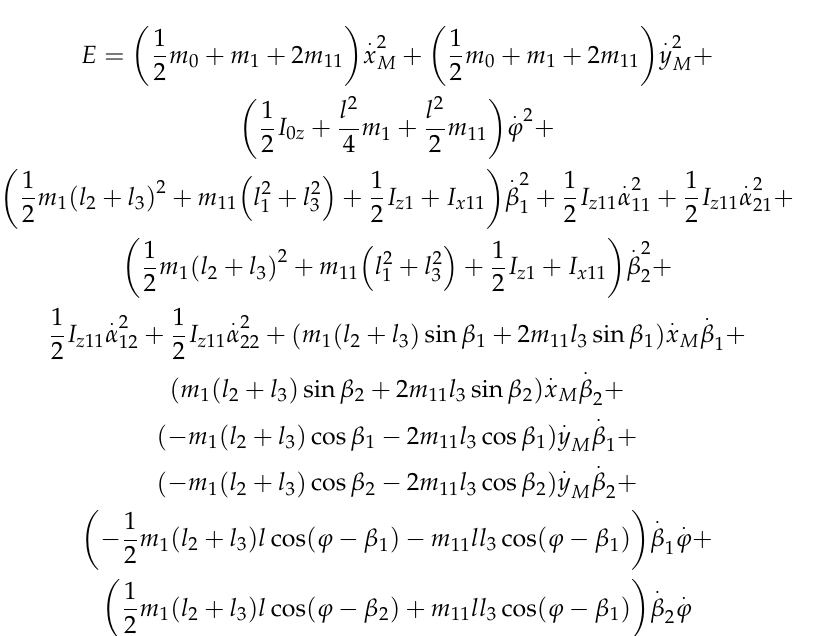
Figure 3. Formation of two robots transporting a beam.